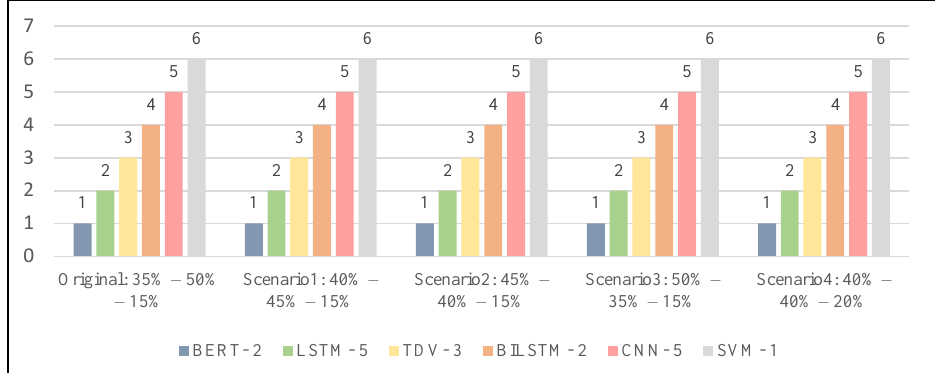
Figure 8. Final ranking of models through sensitivity analysis of the three indicators’ weight distribution.